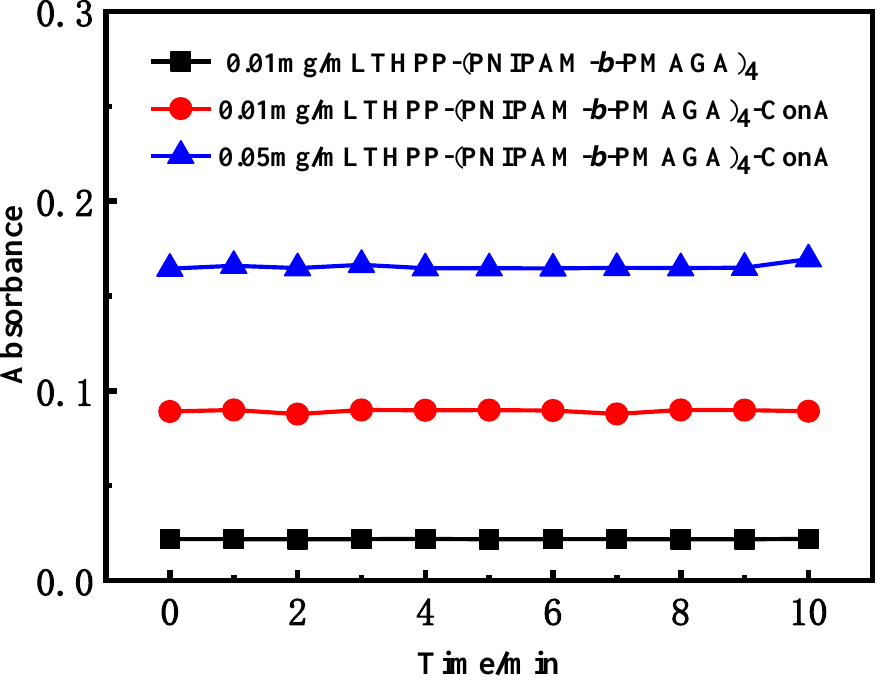
Figure 7. The interactions of Con A (0.5 mg · mL − 1 ) with THPP-(PNIPAM- b -PMAGA) 4 at different concentration.